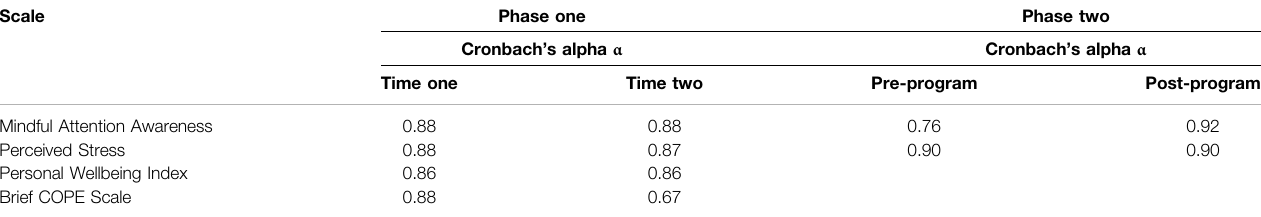
TABLE 3 | Summary of Chonbach ’ s Alpha levels for Phase One and Two . Scale